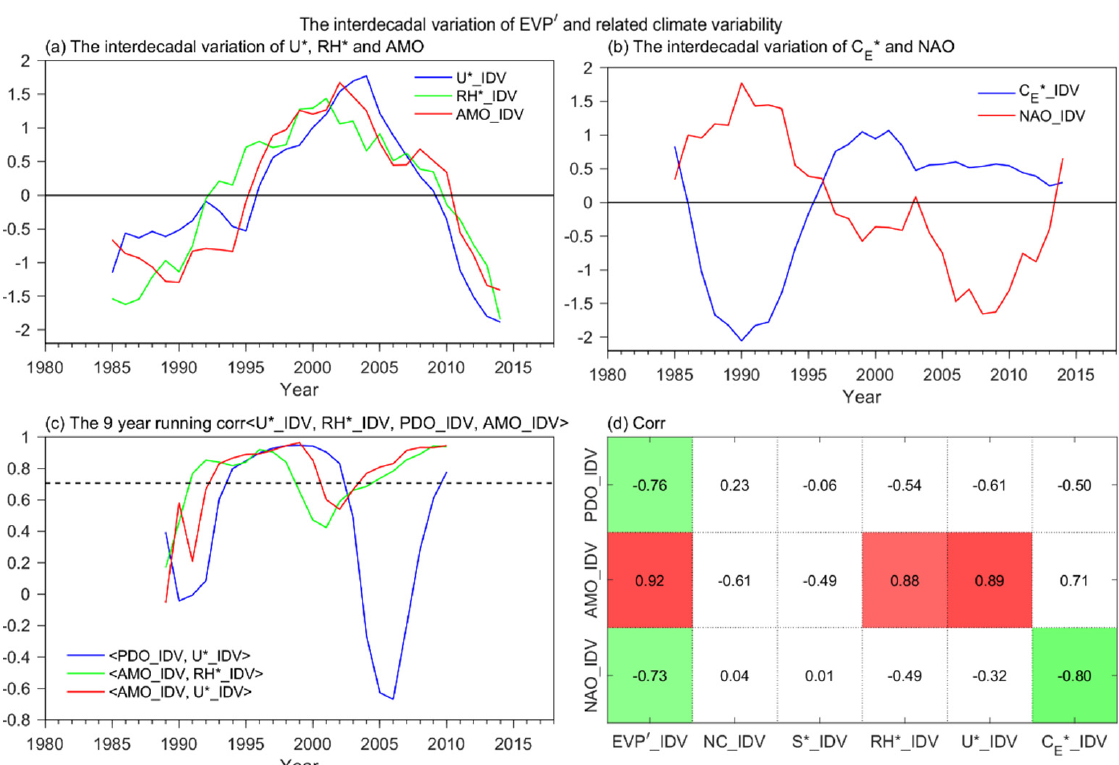
Figure 5. ( a ) The normalized interdecadal variations of U*, PDO, and AMO. ( b ) The normalized interdecadal variations of C E * and NAO. ( c ) The 9 year running correlations between the interdecadal variations of U* and PDO (the values are multiplied by − 1), RH* and AMO, U* and AMO. The black dashed line indicates the 95% confidence level. ( d ) Correlations between the interdecadal variation of PDO, AMO, NAO, and EVP (cid:48) , NC, S*, RH*, U*, C E * over the tropical Indian Ocean. The colors indicate significance with the 95% confidence level (the red and green colors indicate positive and negative correlation coefficients, respectively).